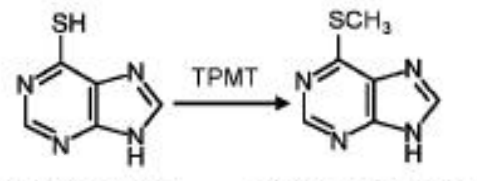
Figura 1. Trasformazione metabolica della 6-mer- captopurina in 6-metil- mercaptopurina ad opera della